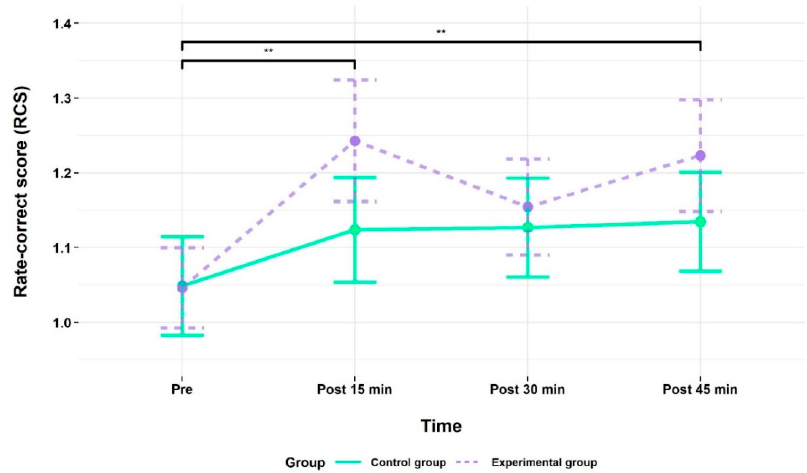
Figure 4. 2-back task performance as measured by the rate-correct score (RCS) for the experimental (EG) and control group (CG) at time point pre (baseline) and at the follow-up measurements after the acute exercise intervention (EG) or listening to the audiobook (CG), respectively. All values are given as mean ( M ); error bars represent one standard error ( SE ) of the mean. ** p <